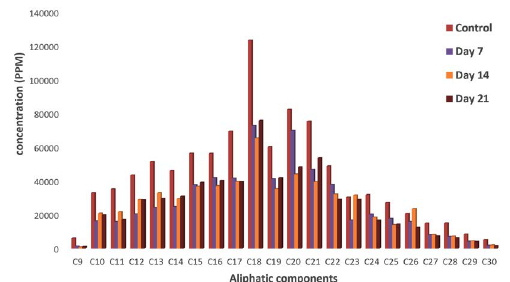
Fig. 6. Concentrations of Aliphatic compounds in residual crude oil from Micrococcus luteus culture fluid